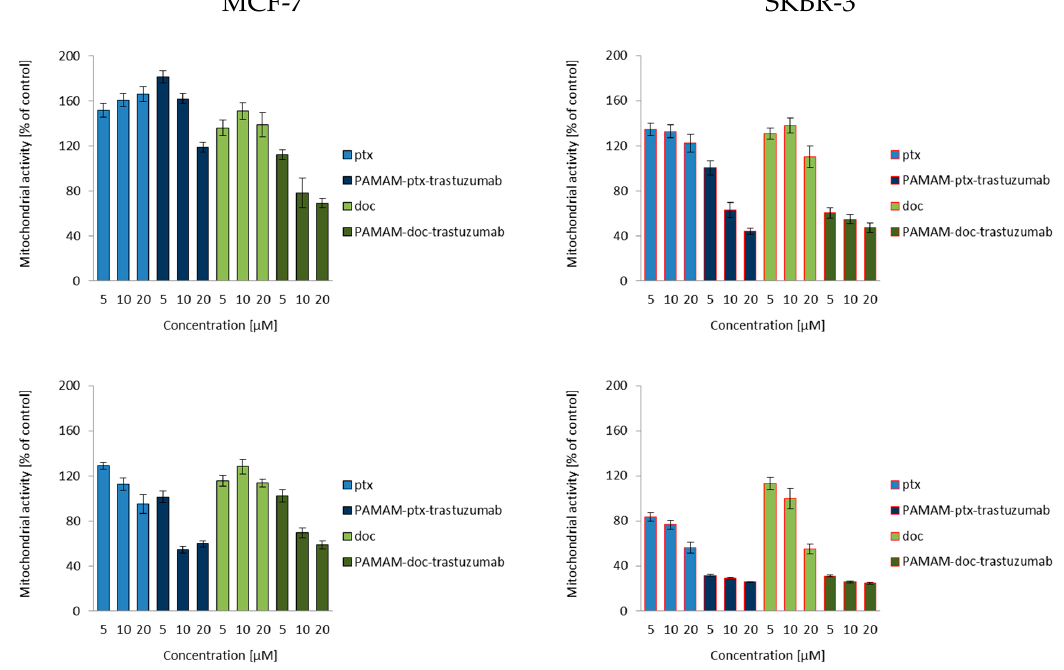
Figure 2. Influence of the PAMAM-ptx-trastuzumab conjugate, PAMAM-doc-trastuzumab conjugate, paclitaxel (ptx) and docetaxel (doc) on the mitochondrial membrane potential in MCF-7 cells ( left panel ) and SKBR-3 cells ( right panel ) after 3 and 24 h incubation. The results are presented as the mean ± standard deviation of three